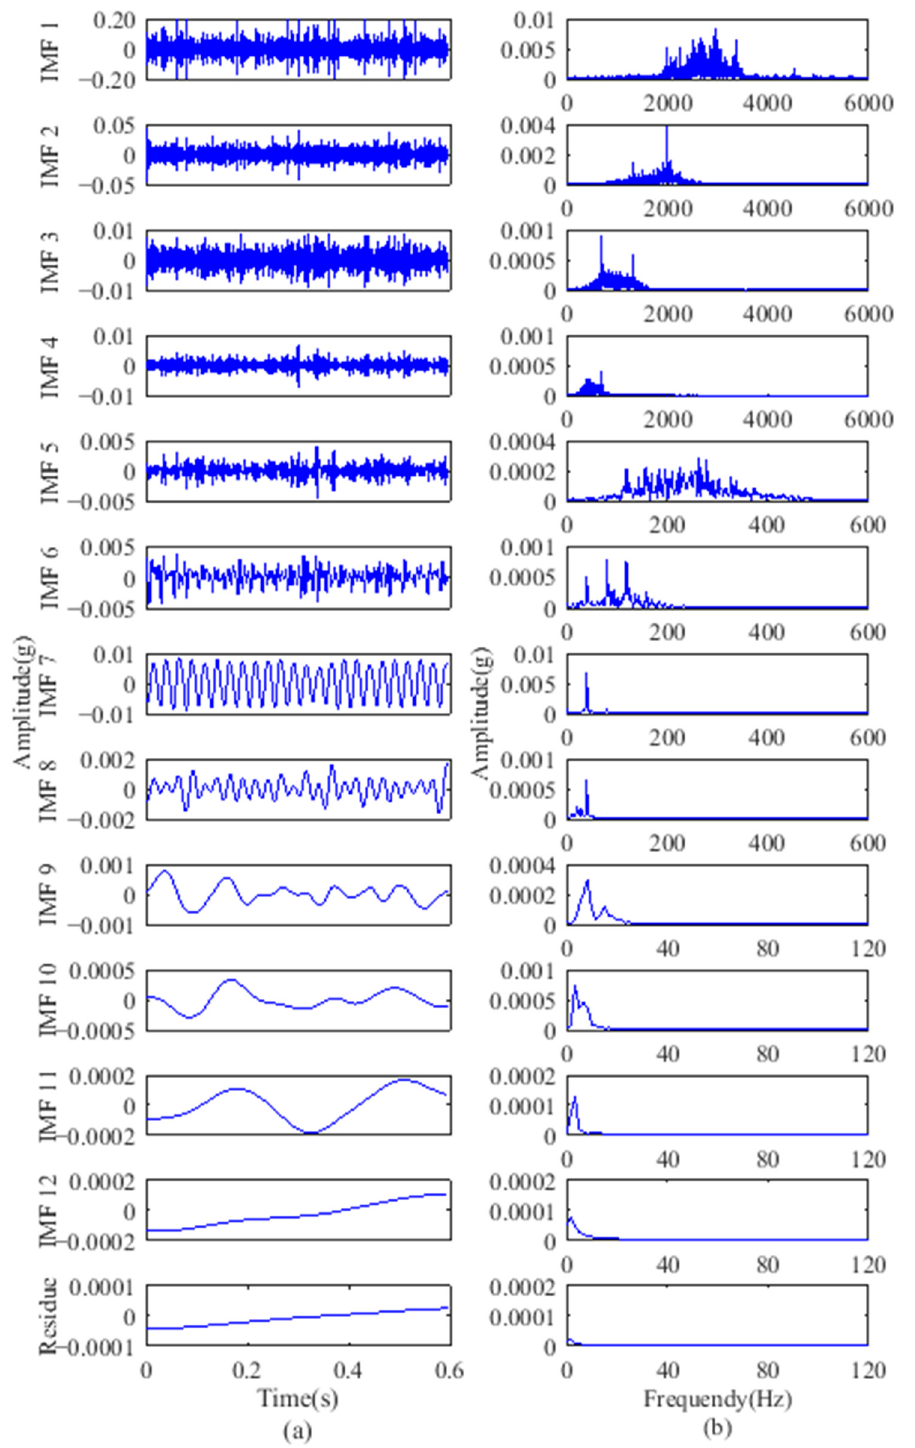
Figure 8. EEMD results of gear with breakage: ( a ) IMFs; ( b ) frequency spectrums.